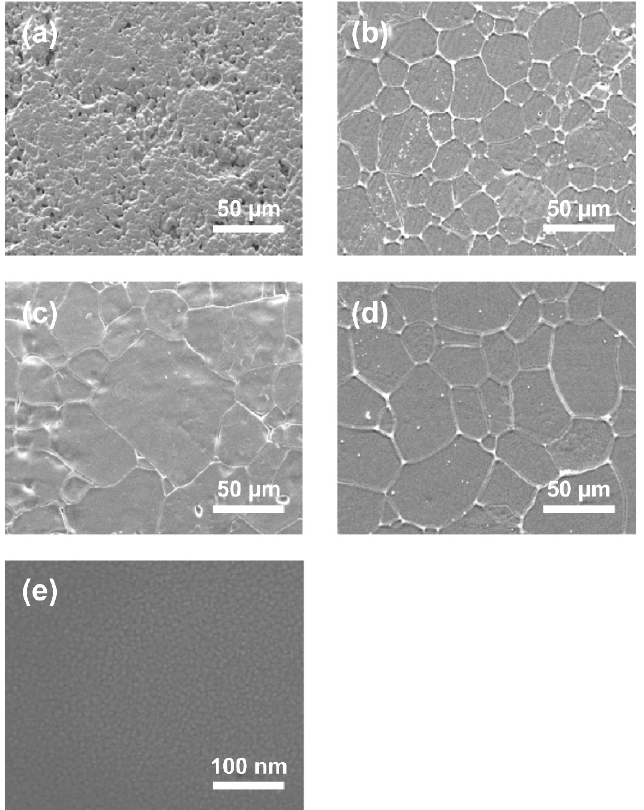
Figure 3. SEM images of (Sr 0.99 Eu 0.01 )Al 2 O 4 -sintered body: ( a ) conventionally sintered body; ( b , c ), and ( d ) hot-press-sintered body that were heat processed for 30 min, 2 h, and 4 h, respec- tively. ( e ) SEM images of the (Sr 0.99 Eu 0.01 )Al 2 O 4 thin